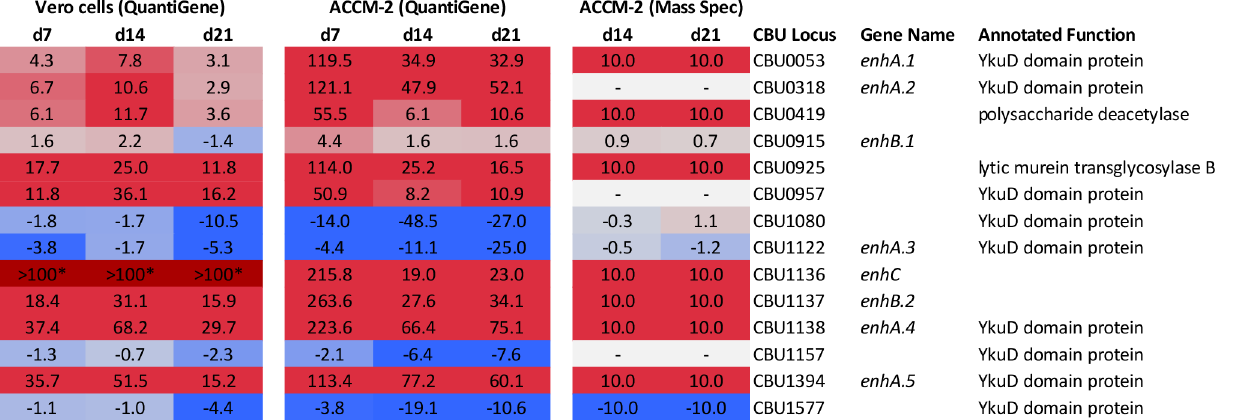
Fig 5. QuantiGene and mass spectometry verification of gene expression detected by microarray for cell wall remodeling genes. RNA from Coxiella -infected Vero cells or bacteria grown in ACCM-2 was subjected to QuantiGene analysis to determine expression levels. Fold-increase in mRNA levels at 5, 7, 14, and 21 days post-infection relative to 3 days post-infection with a corresponding color code is depicted. A value of > 100 indicates signal was not detected with the day 3 RNA samples. Mass spectrometry of C . burnetii grown in ACCM-2 for 3, 14, and 21 days. Depicted are normalized peptide scores. Relative expression of protein at 14 and 21 days post-infection is shown as log2 ratio compared to 3 days post-infection. A value of 10 indicates no peptide was detected in day 3 bacteria. A value of -10 indicates no peptide was detected in day 14 and day 21 bacteria. A minus sign indicates no peptide was detected at any time